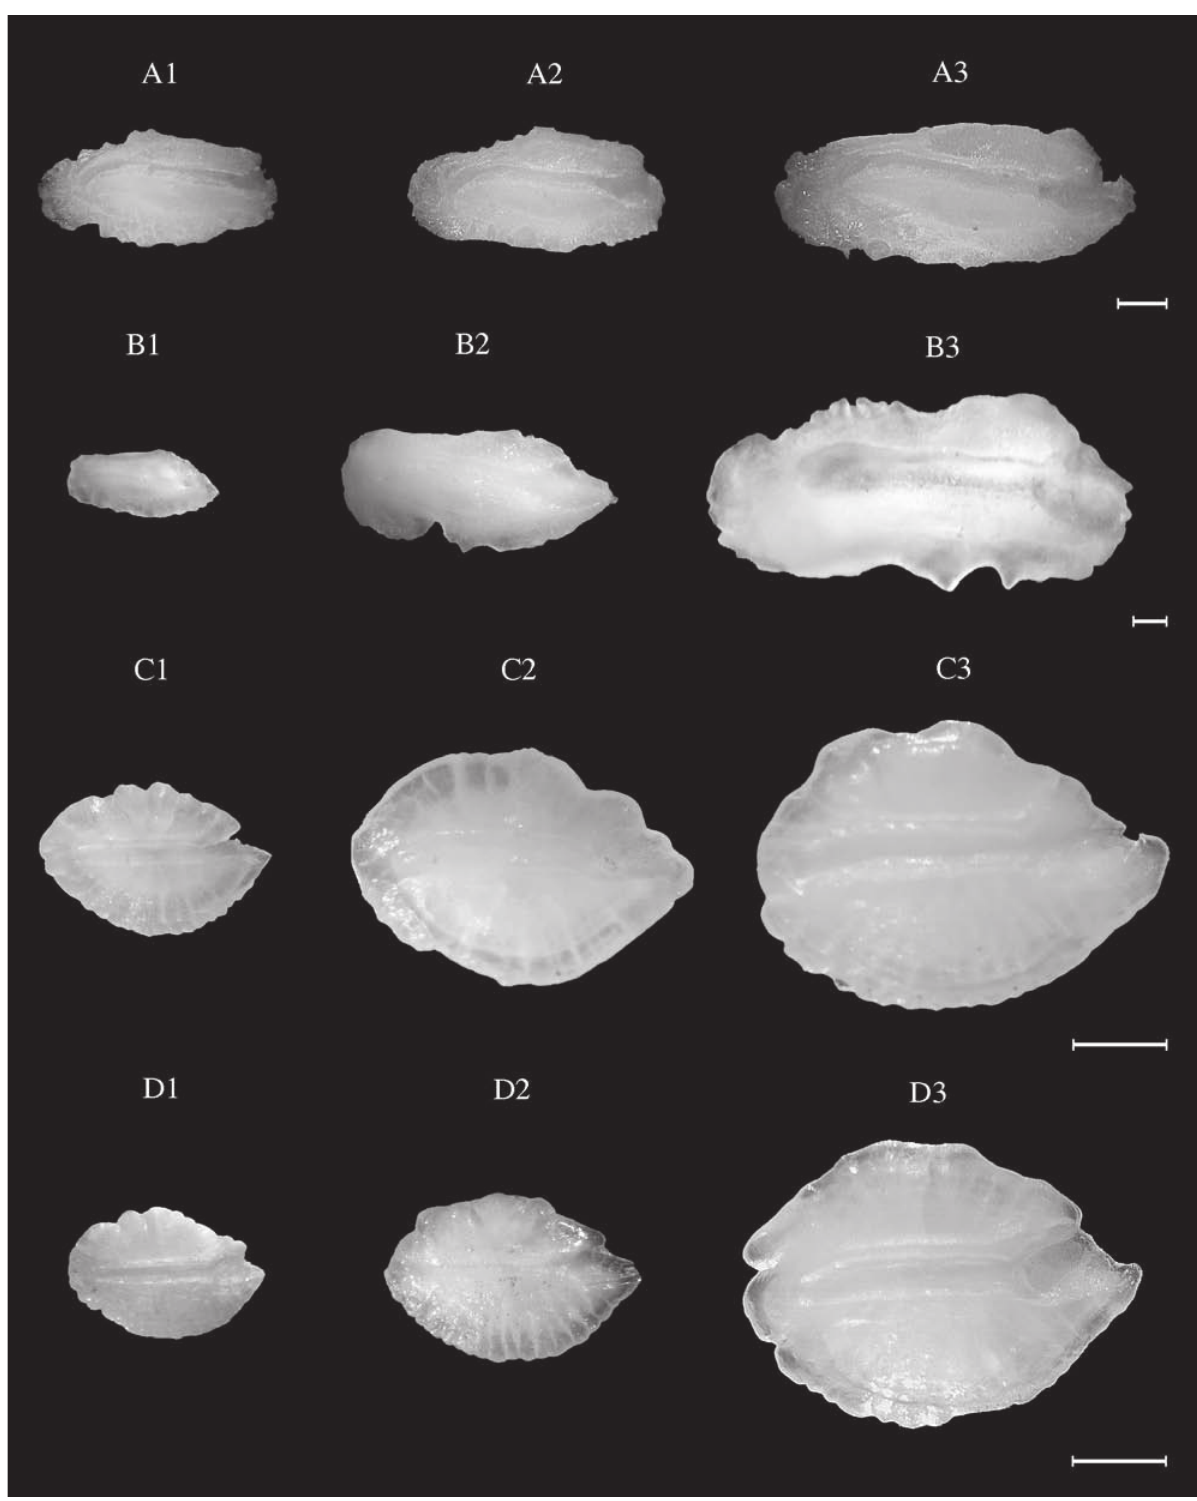
Fig. 36. – Liza saliens (WM). TL: A1, 14.0 cm; A2, 18.5 cm ; A3, 23.0 cm. Mugil cephalus . TL: B1, 11.6 cm (NEA); B2, 32.6 cm (NEA); B3, 56.0 cm (WM). Atherina boyeri (NEA). TL: C1, 6.0 cm; C2, 9.5 cm; C3, 13.7 cm. Atherina presbyter . TL: D1, 5.8 cm (CEA); D2, 7.6 cm (CEA); D3, 12.1 cm (NEA). Scale bar = 1